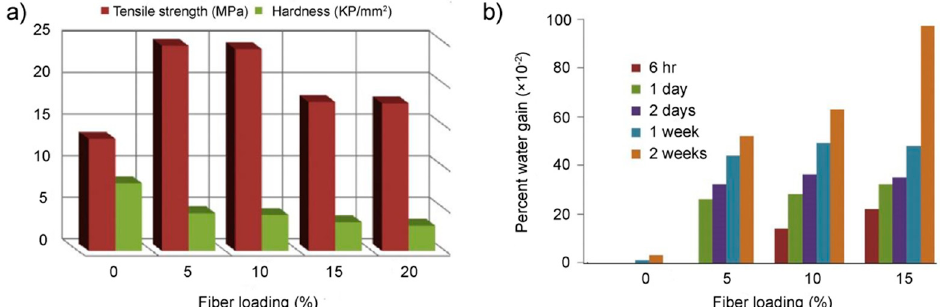
Figure 4. ( a ) Tensile strength and hardness; ( b ) percentage of water absorption of PE/corn husk fiber composites with different fiber percentages. Adapted from Ahmed Youssef et al. [40].